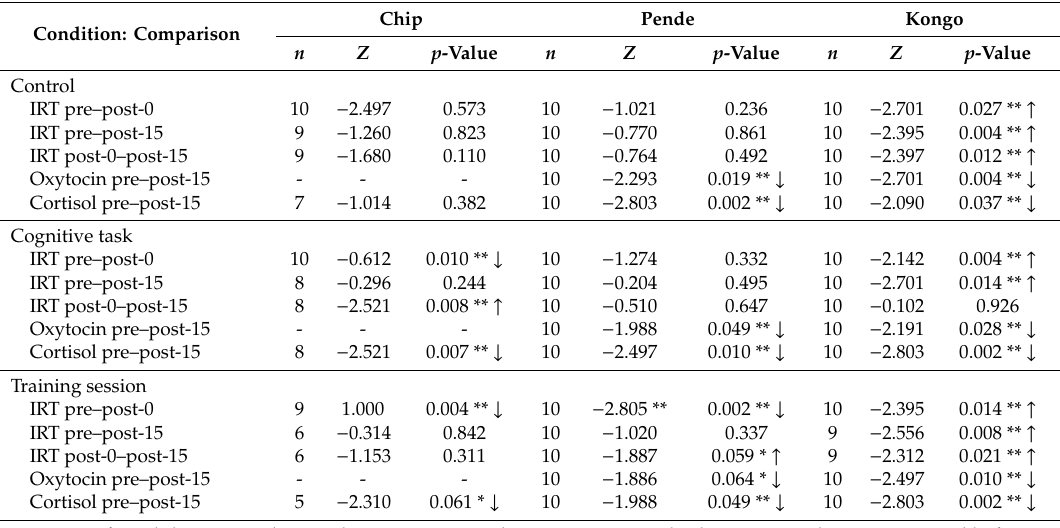
Table 2. Pre-post comparisons following human–animal interactions (cognitive task or training session) and a control condition for three western lowland